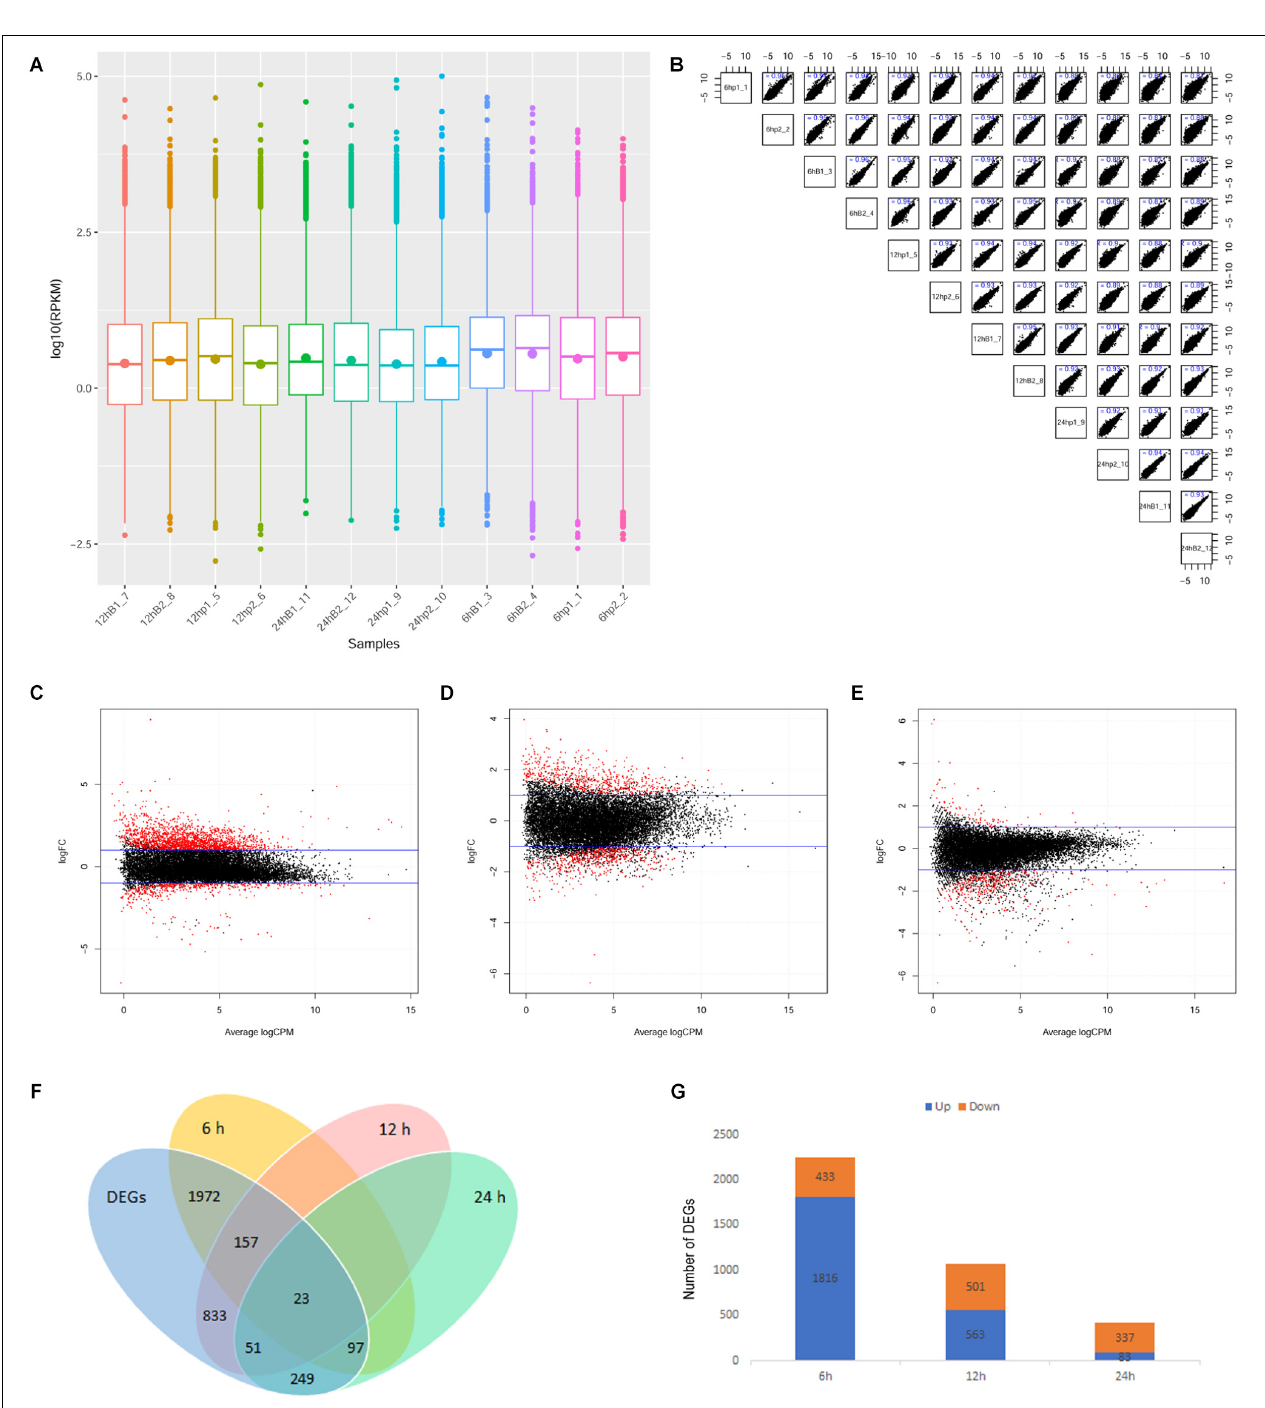
FIGURE 2 | Overview of mRNA profiling in this study. (A) Boxplot of the gene expression levels of various samples. Box charts for each region correspond to the maximum, upper quartile, median, lower quartile, and minimum of log10 (RPKM). (B) Scatter plot of the gene expression correlation in this study. The abscissa and ordinate represent log10(RPKM) of different sample genes respectively. (C–E) MA plot indicating upregulated and downregulated differentially expressed genes (DEGs) in the ex vivo model 6, 12, and 24 h after Bb infection. The abscissa represented Average log2 (CPM). The ordinate represented log2 (FC). The two blue lines represent the threshold of differentially expressed genes and the points outside the threshold are marked in red. log2 (FC) > 1 represents upregulated and log2 (FC) < -1 represents downregulated. (F) Venn diagram representing the overlap of identified DEGs. Overlaps showing 6 h-DEGs ( n = 2249; yellow), 12 h-DEGs ( n = 1064; red), 24 h-DEGs ( n = 420; green), 6, 12, 24 h-DEGs ( n = 3382; blue). (G) Number of upregulated and downregulated DEGs at 6, 12, and 24